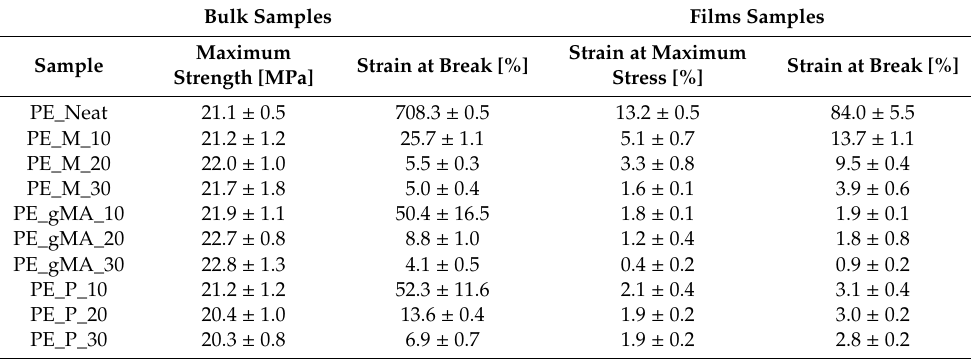
Figure 2. Images of bulk and thin film samples ( a ), Young Modulus and strain at maximum stress for bulk BioPE / CSS composites ( b , c ) and Young Modulus and strain at maximum strength for thin films BioPE / CSS composites ( d , e ). Table 1. Results of tensile test for CSS_M, CSS_A and CSS_P BioPE composites, bulk and films samples. Bulk Samples Films